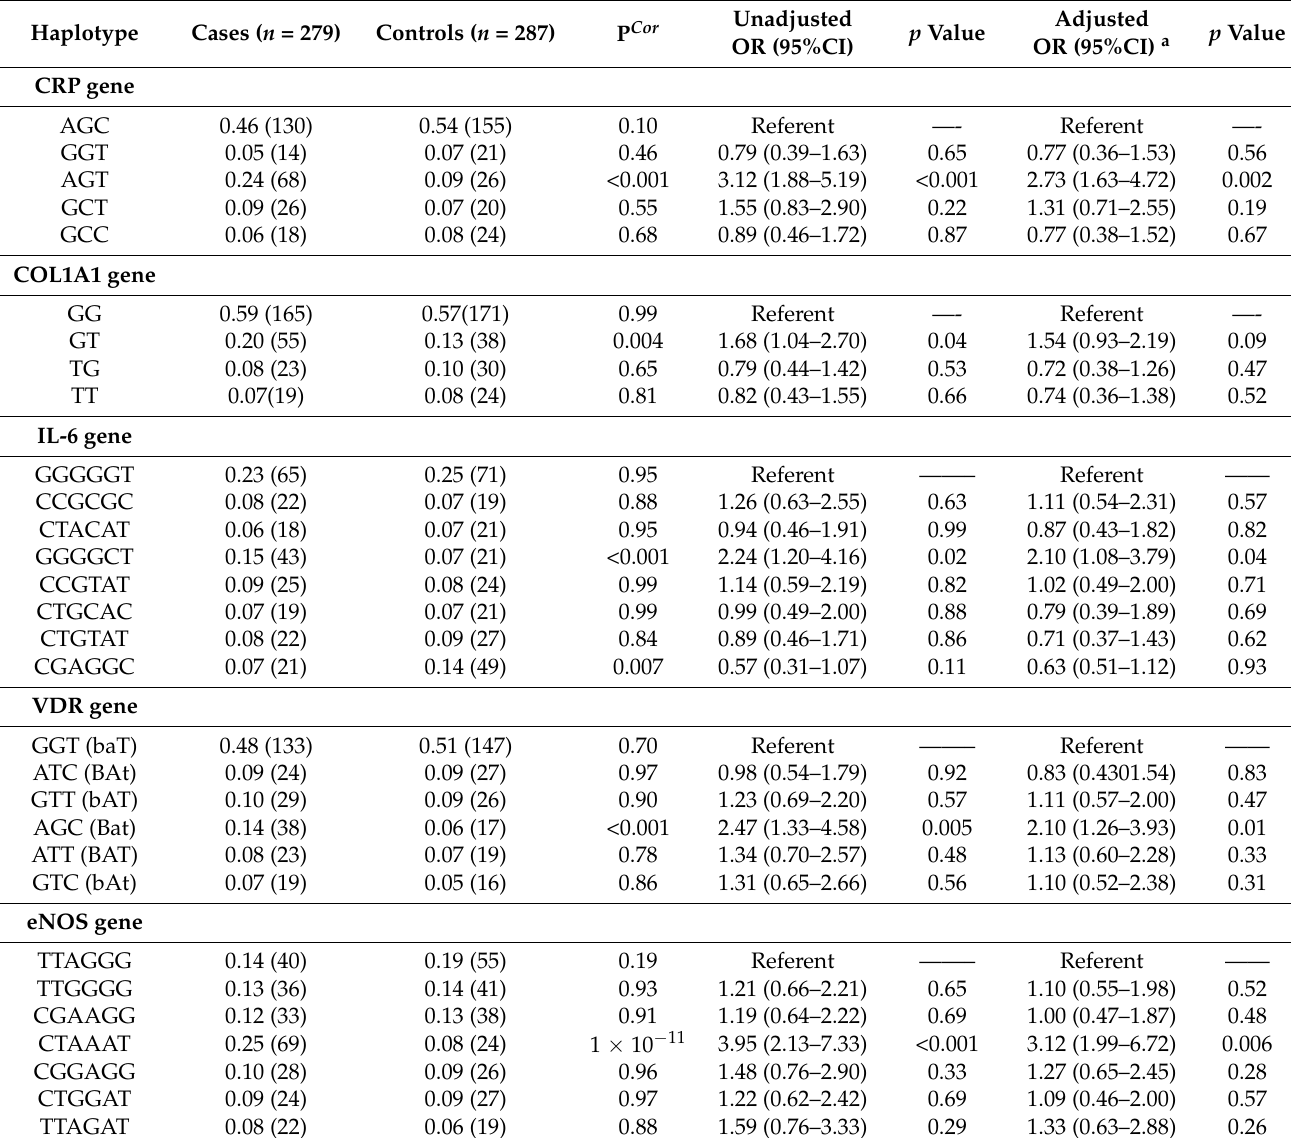
Table 4. Haplotypes of CRP, COL1A1, IL-6, VDR, and eNOS genes for the risk of